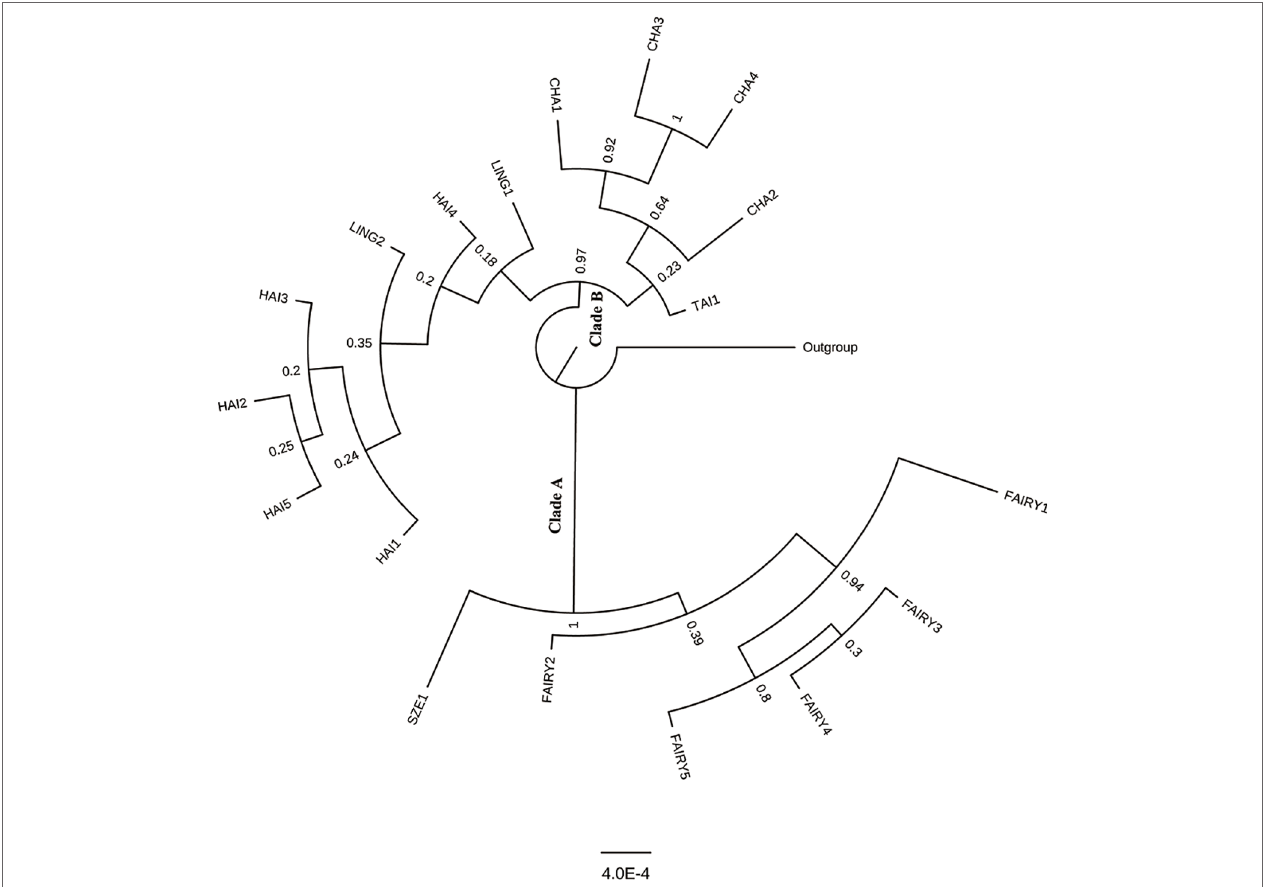
FIgUrE 5 | Phylogenetic relationships among 18 populations in the Cycas taiwaniana complex inferred from combined two single-copy nuclear genes and two chloroplast intergenic spacers based on Bayesian inference.